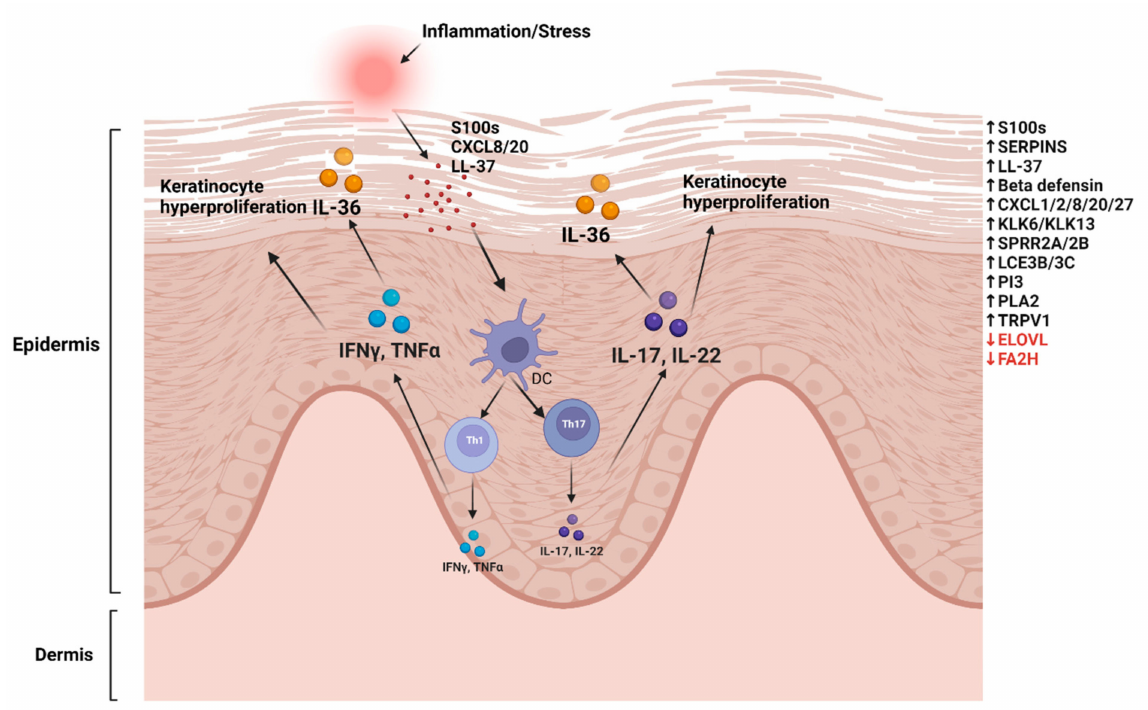
Figure 1. Molecular changes in psoriasis inflammation or cell stress induces the release of S100 proteins, AMPs, and cathelicidins. These activate dendritic cells (DCs) to induce T-cell proliferation to Th1 and Th17. IL-17/Il-22 induces epidermal (keratinocyte) proliferation, inflammatory cell infiltration, paraketosis, and acanthosis. IL17 and TNF- α upregulate IL-36 expression in inflamed skin. Gene marked in black represent upregulated genes, and red represents downregulated genes (as reviewed in the manuscript). The image was made by using Biorender